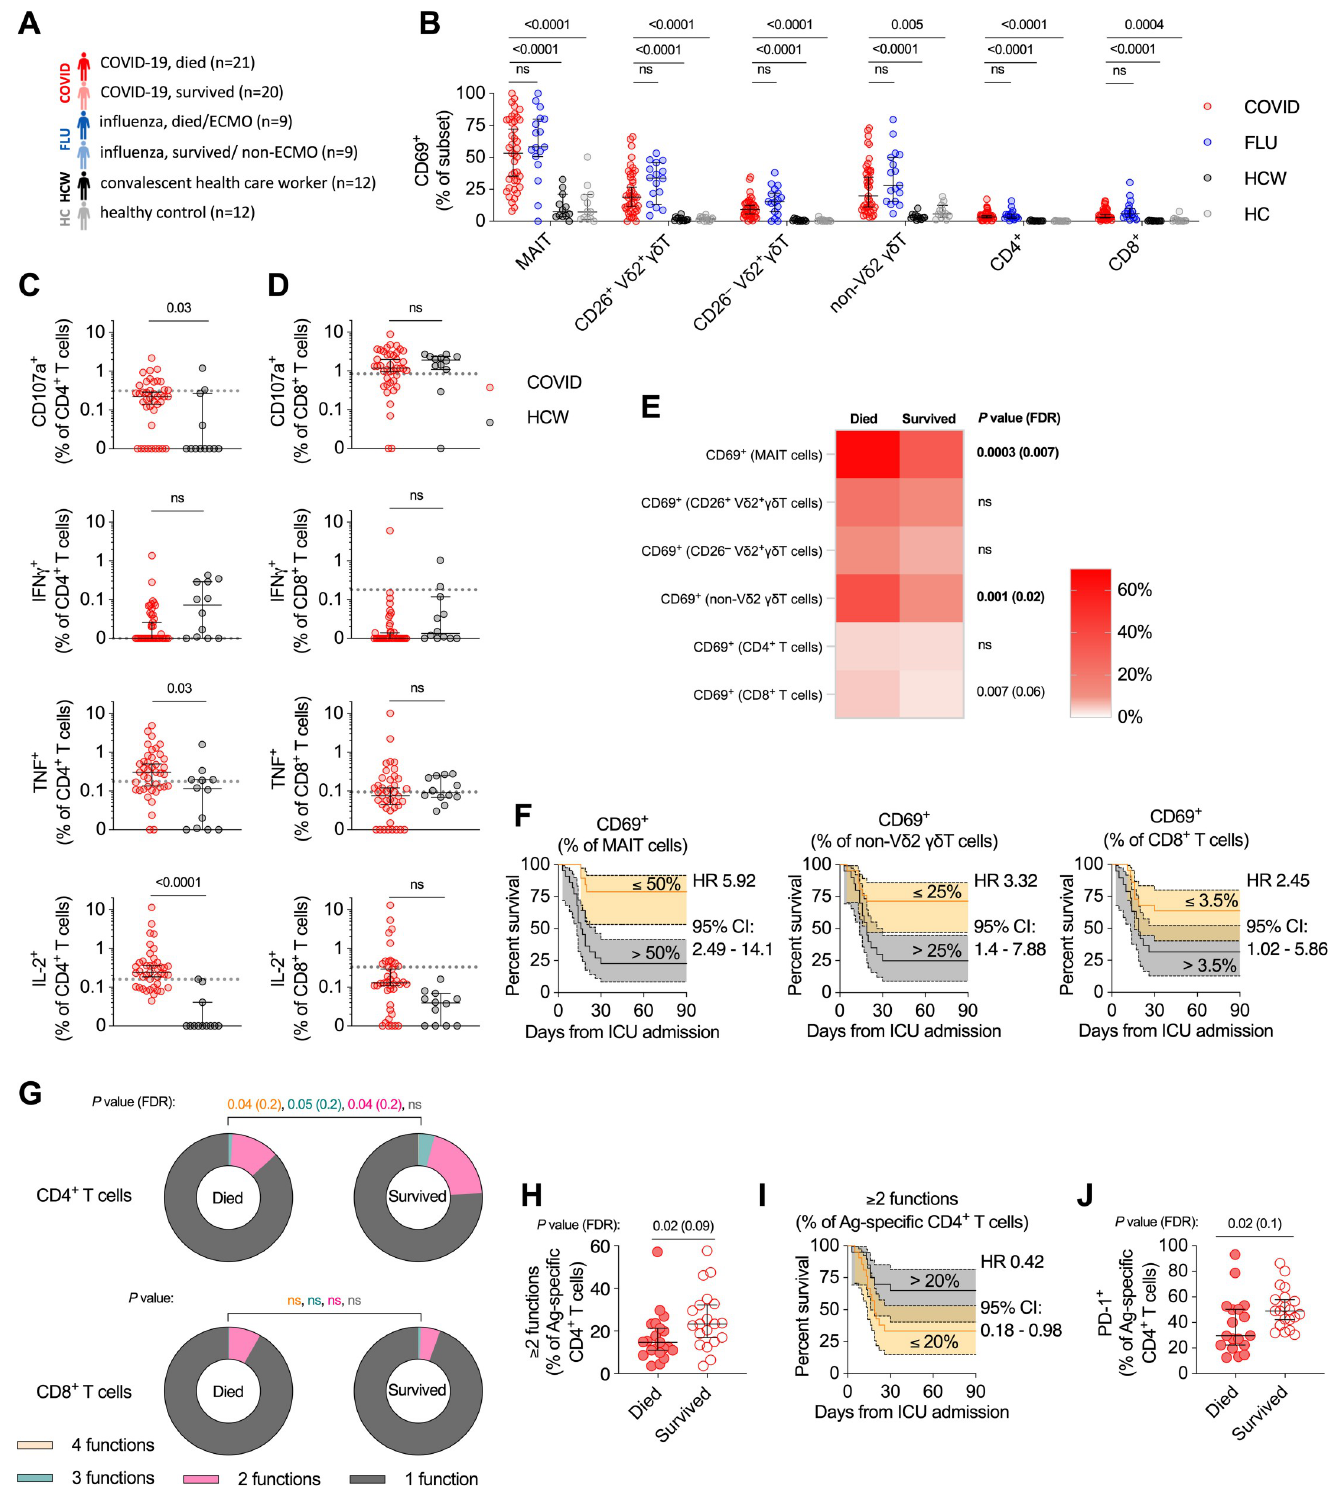
Fig 1. Relationship between T cell activation and mortality in critically ill COVID-19 patients. (A) Schematic of the study cohort. All COVID-19 and influenza patients were critically ill. Convalescent health care workers had mild disease. Samples from healthy controls were collected pre-pandemic. (B) Direct ex vivo measurement of general activation of each T cell subset. (C-D) Quantification of spike-specific CD4 + T cells (C) and CD8 + T cells (D) in acute critically ill COVID-19 patients and health care workers. Dashed line indicates the upper 95% confidence interval for responses detected in pre-pandemic healthy controls. (E) Median ex